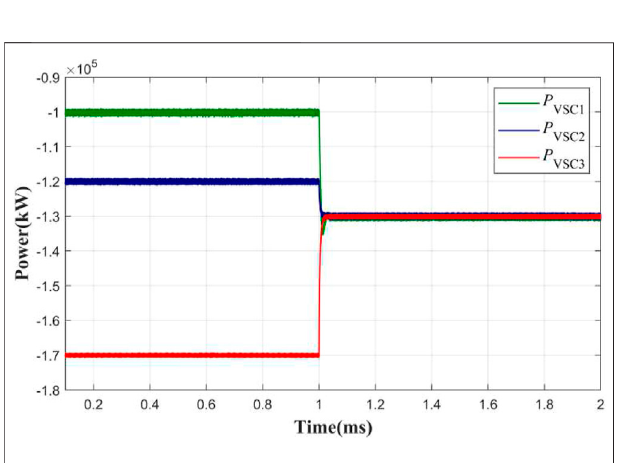
FIGURE 6 | Power fl ow control response